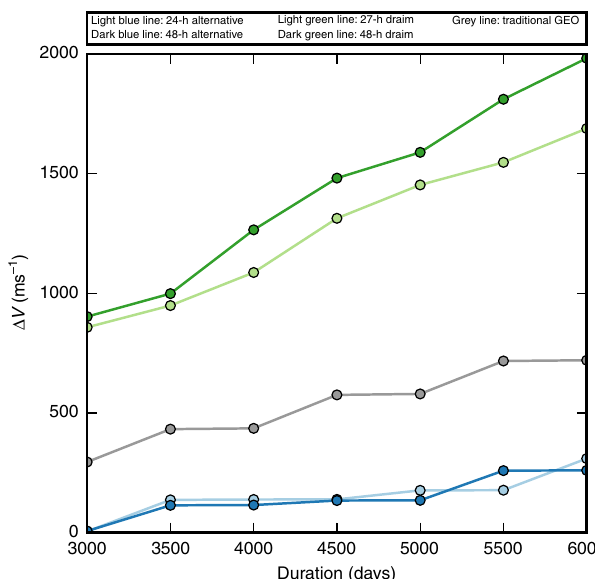
Fig. 2 Maximum single-satellite station-keeping Δ V requirement. Mission duration varies from 3000 to 6000 days to capture a broad cross section of typical geostationary satellite lifetimes. Both constellations (light and dark blue circles) perform better than the GEO (gray circles) or benchmark Draim con fi gurations (light green and dark green circles). While both 24- and 48-h constellations outperform the GEO con fi guration in terms of station-keeping propellant requirements by ~60%, the 24-h constellation retains the same orbit altitude, permitting similar conditions for